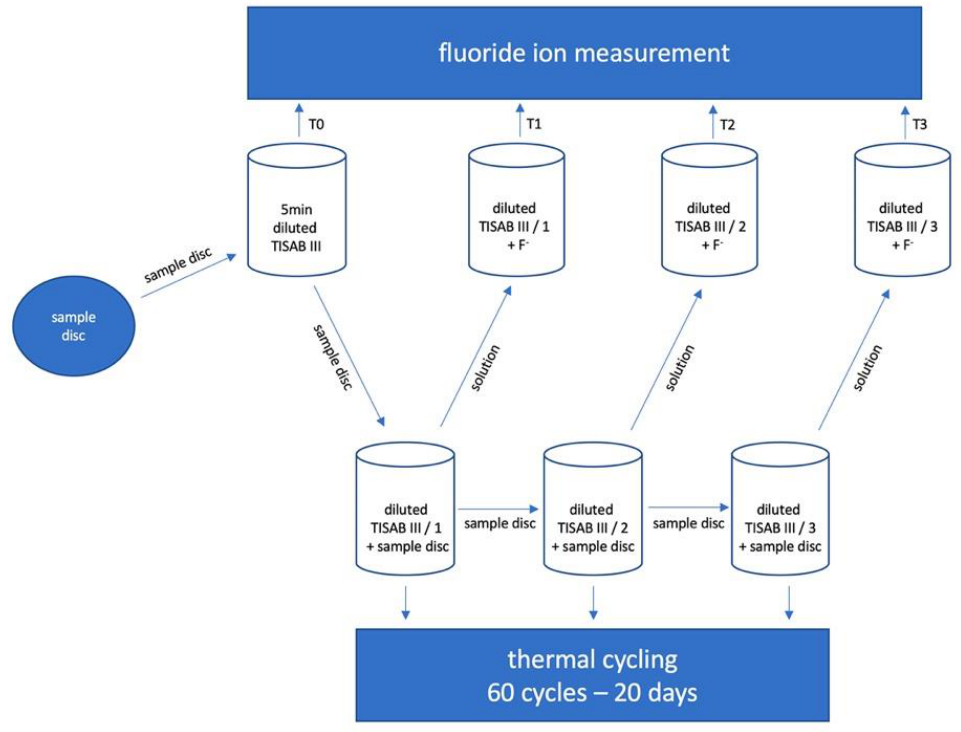
Figure 1. Setup of the present study (TISAB III: Total Ionic Strength Adjustment Buffer III, F − : released fluoride ion concentration).